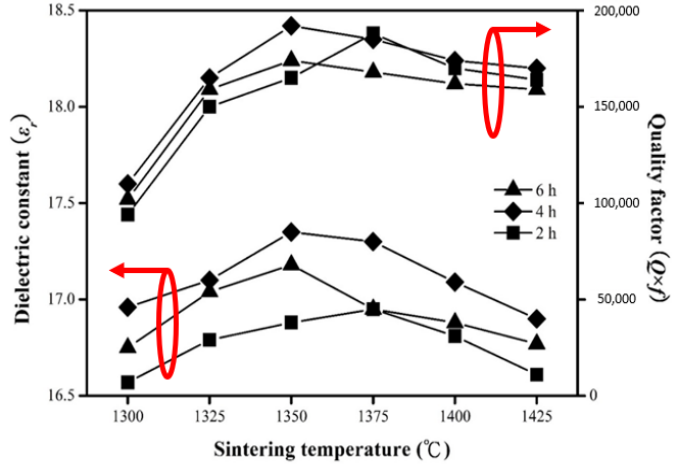
Figure 6. The dielectric constant and quality factor of the MNT ceramics as a function of the S.T. for varied holding time. The left and right circles with arrows Dielectric constant and Quality factor, respectively.